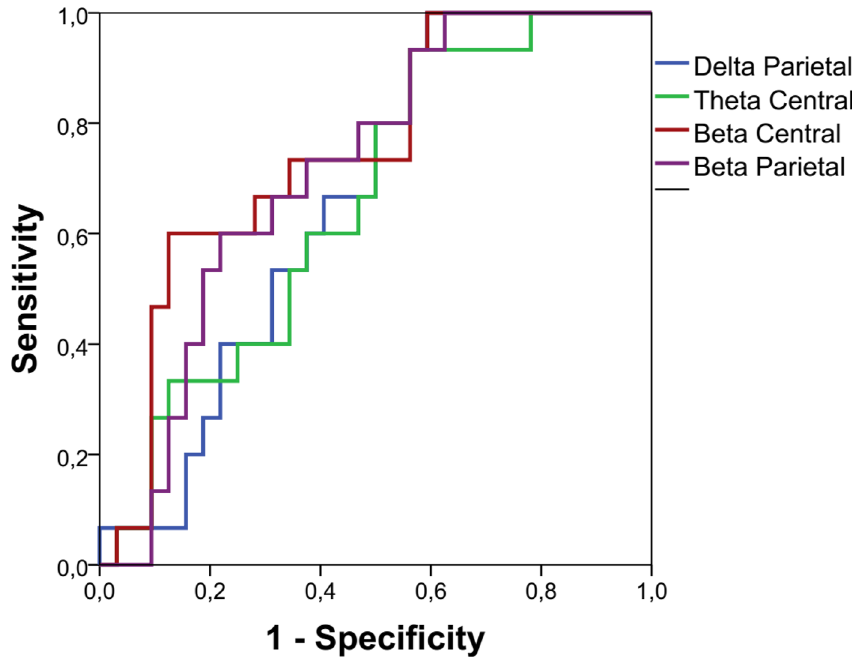
Figure 3. Receiver-operator curves (ROCs) for the parietal delta, central theta, central beta and parietal beta peak amplitudes ((EO-EC variation) of the Spectral power density